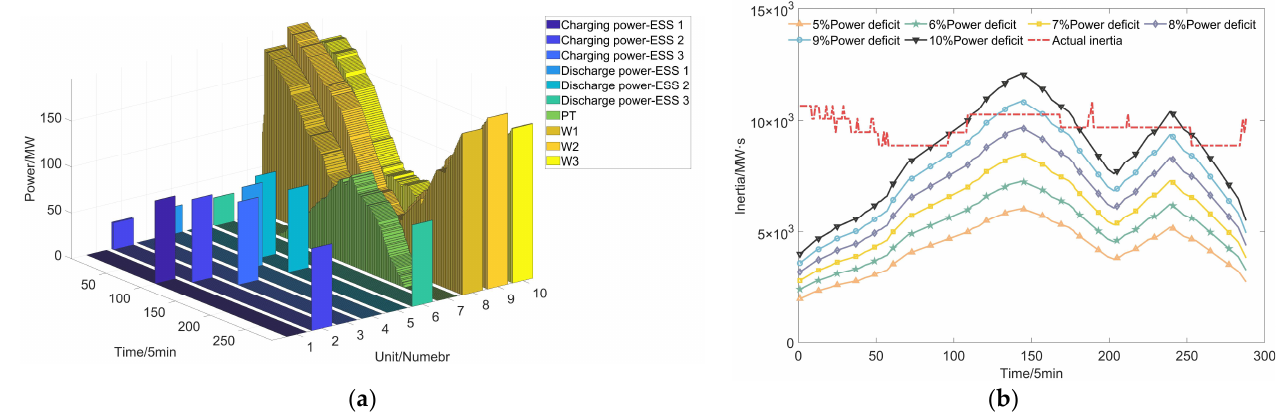
Figure 5. ( a ) Results for real-time scheduling. ( b ) Inertia demand for different power deficits in the real-time scheduling period.